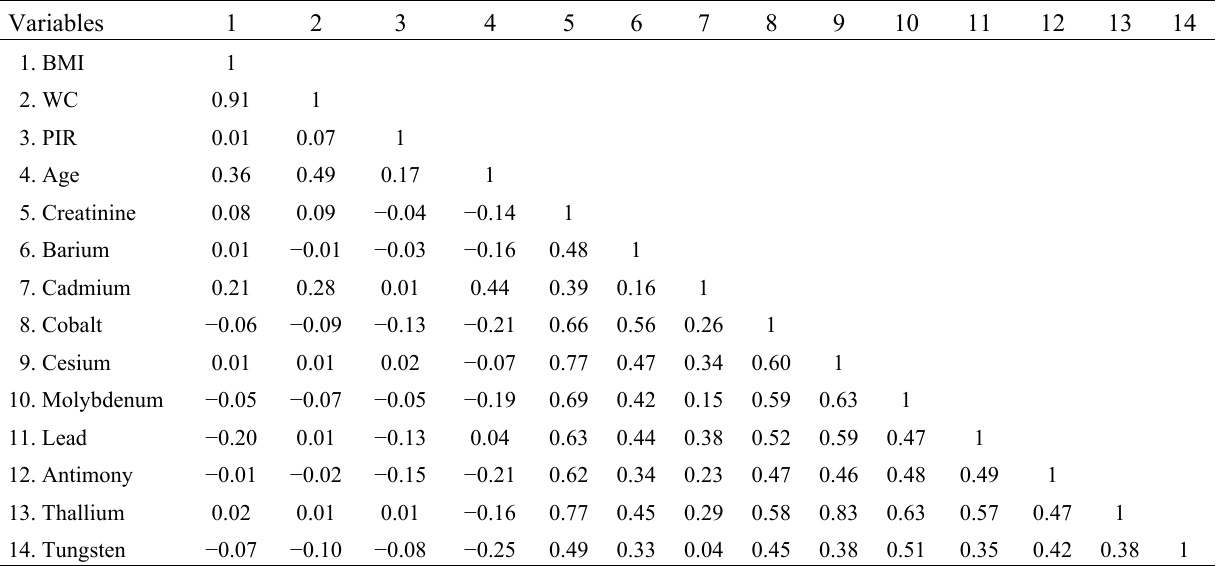
Table 2. Correlations Among all Variables in the